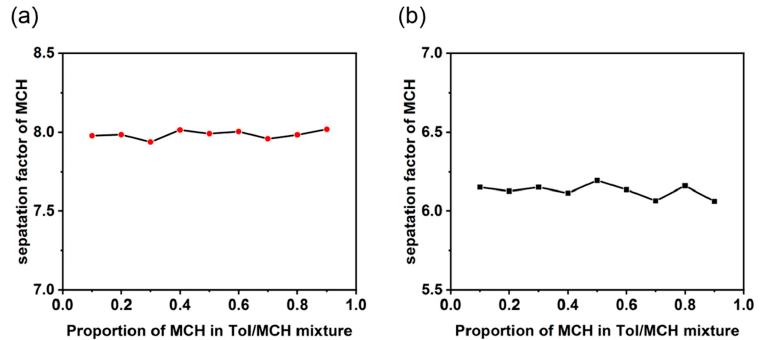
Figure 3. The relationship between the separation factor of MCH and the proportion of MCH after an extraction treatment by ( a ) WP5 and ( b ) WP6.